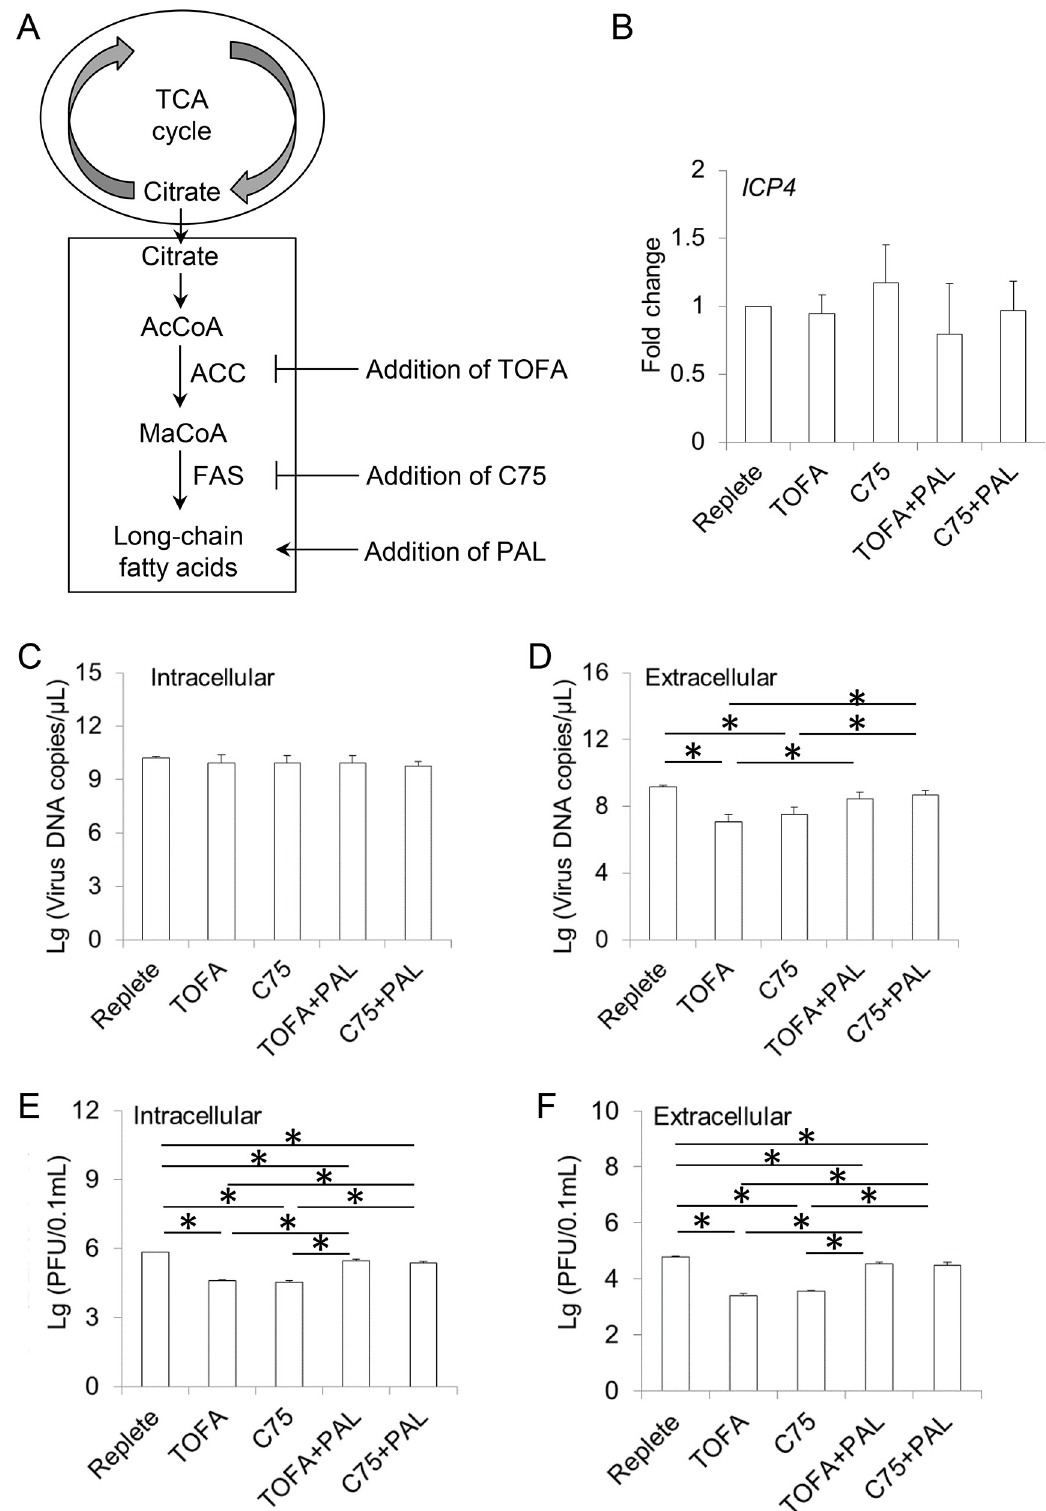
Fig 7. Effect of fat acid synthesis on ILTV infection. (A) Schematic presentation showing the experimental design. LMH cells were cultured in replete medium in the presence or absence of two inhibitors of fat acid synthesis, namely acetyl-CoA